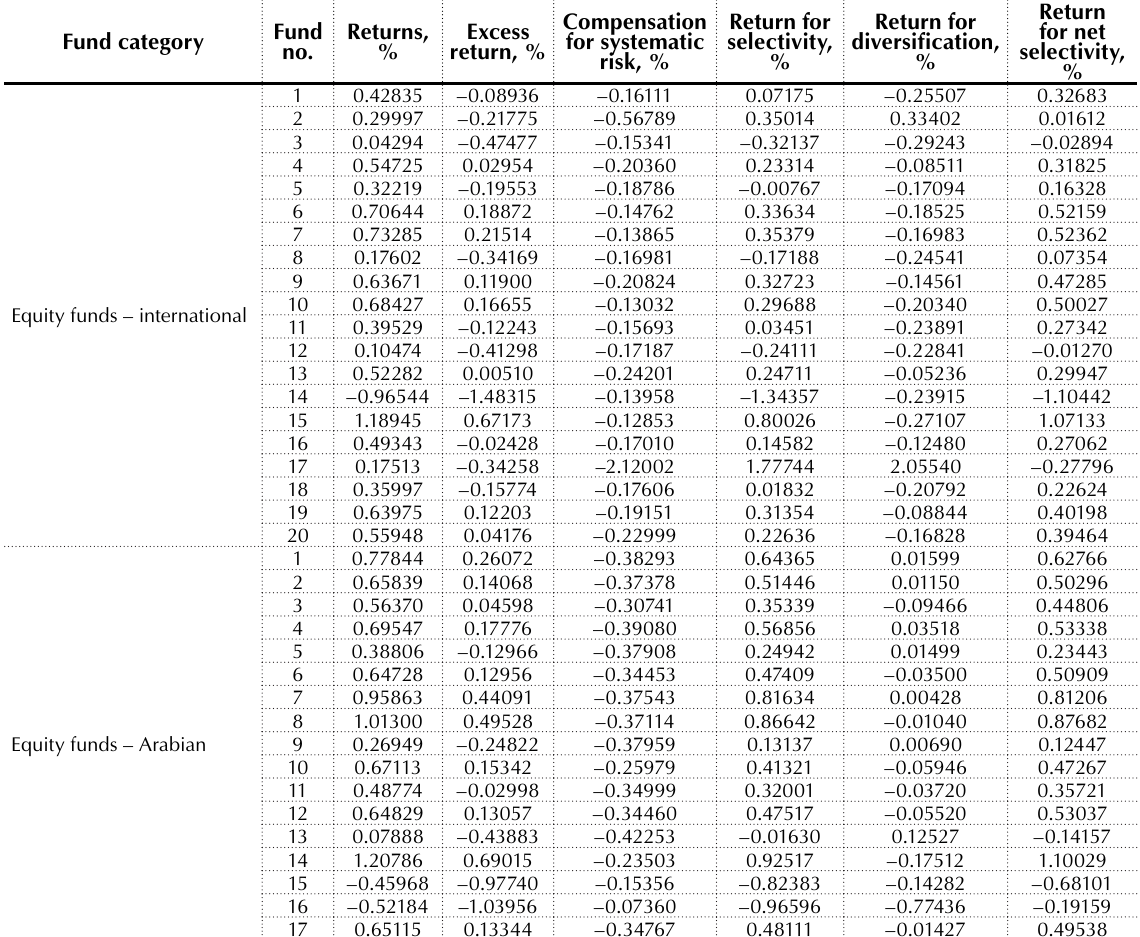
Table 2 (cont.). Fama’s break up of Saudi equity funds returns Fund